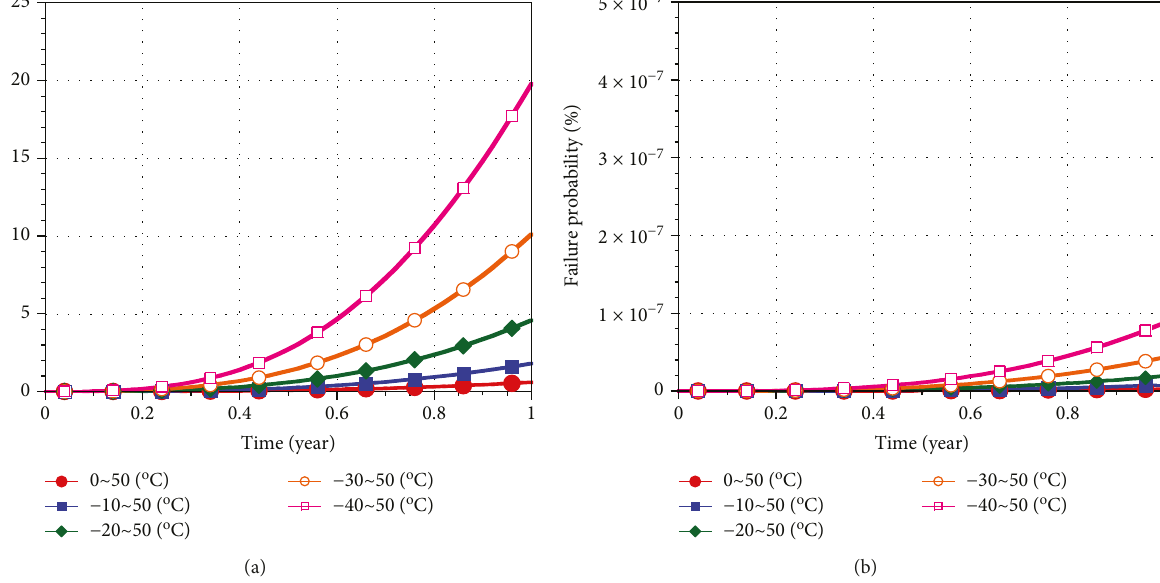
Figure 12: Time histories of the failure probabilities of U5 and U2 packages under LEO thermal environment ((a) U5 package and (b) U2